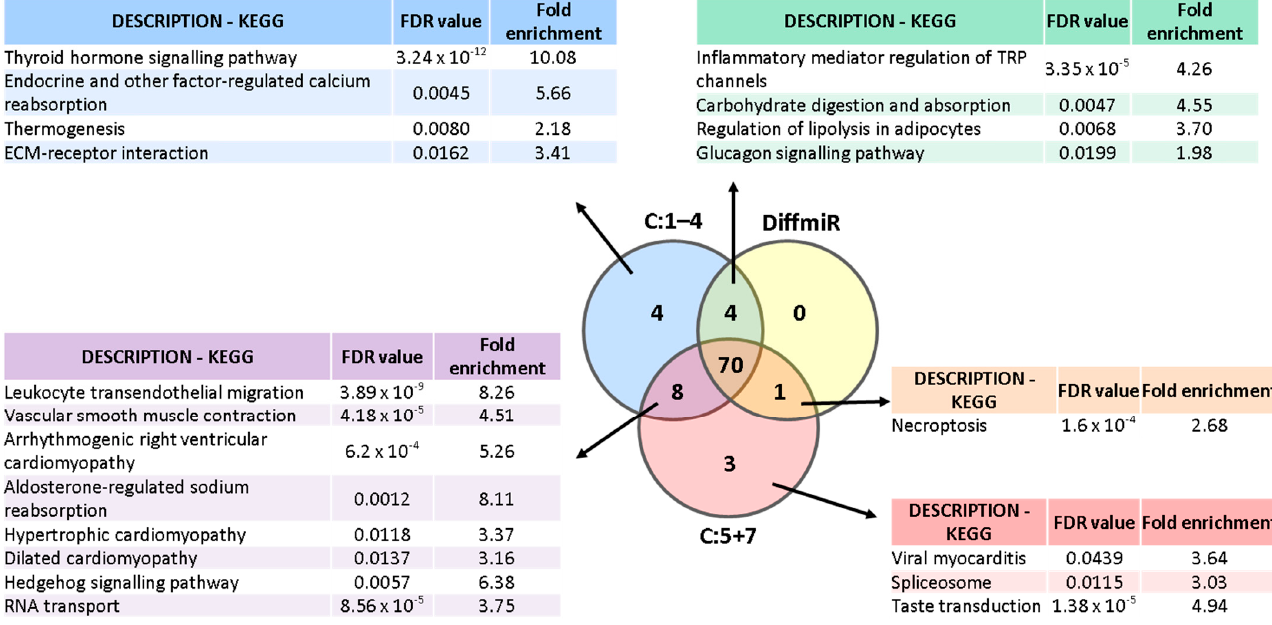
Figure 6. Venn diagram of enriched pathways identified for each group of miRNAs. C:1–4: miRNAs included in clusters 1–4 of the main PPI network (includes let-7a-5p , miR-107 , miR-125a-5p , miR-139-5p , miR-150-5p , miR-30b-5p and miR-342-3p ); C:5+7: miRNAs included in clusters 5 and 7 of the main PPI network (includes miR-107 , miR-139-5p and miR-150-5p ); DiffmiR: miRNAs included in clusters 1–4 but not in clusters 5 and 7 of the main PPI network (includes let-7a-5p , miR-125a-5p , miR-30b-5p and miR-342-3p ).